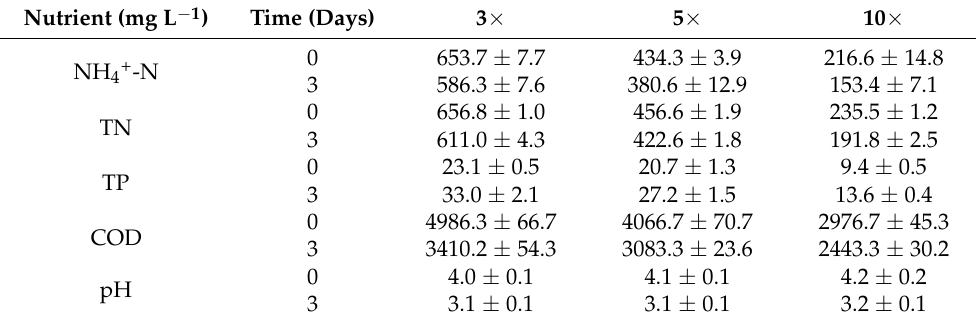
Table 2. Chemical composition of 3-fold (3 × ), 5 × , and 10 × diluted anaerobic digestion piggery effluents (ADPEs) before and after three-day fungal decolorization. The results are presented as arithmetic means ± standard deviations ( n =